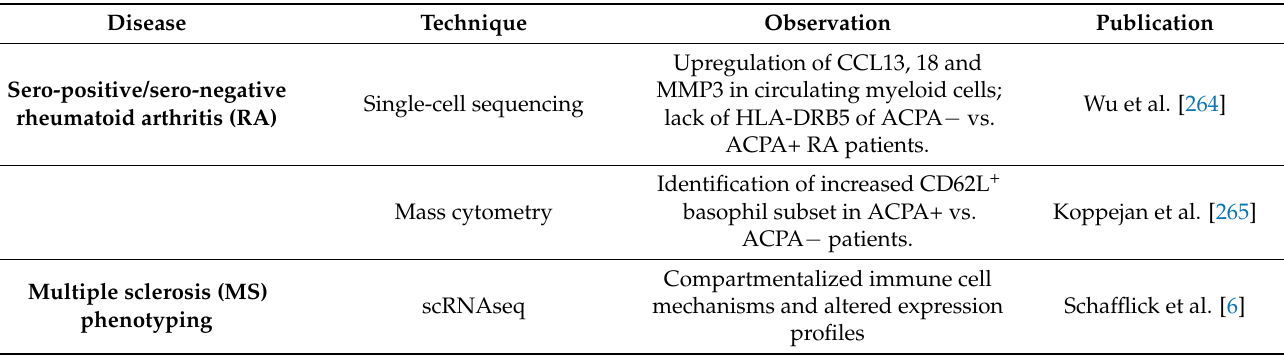
Table 3. Examples of applications of immune cell